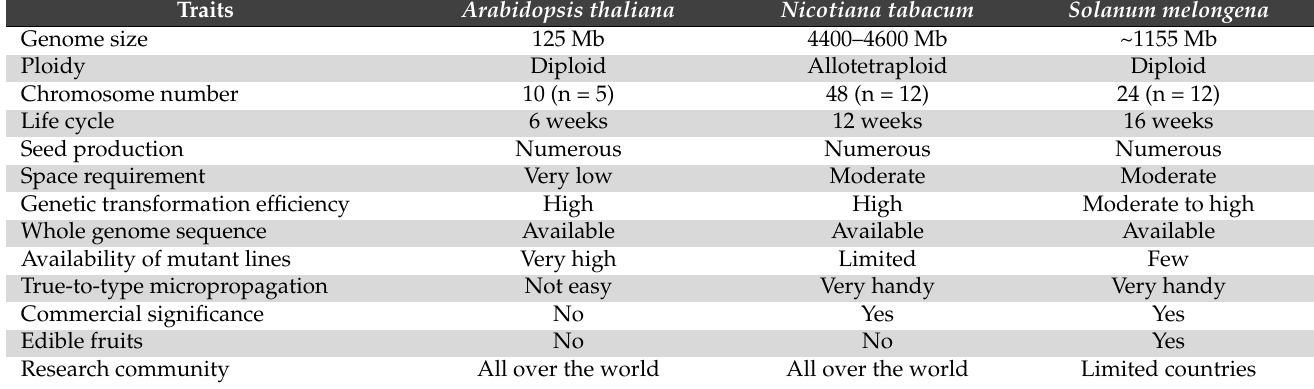
Table 7. Comparison of traits to be considered as a model plant for cellular and molecular biology of flowering plants.